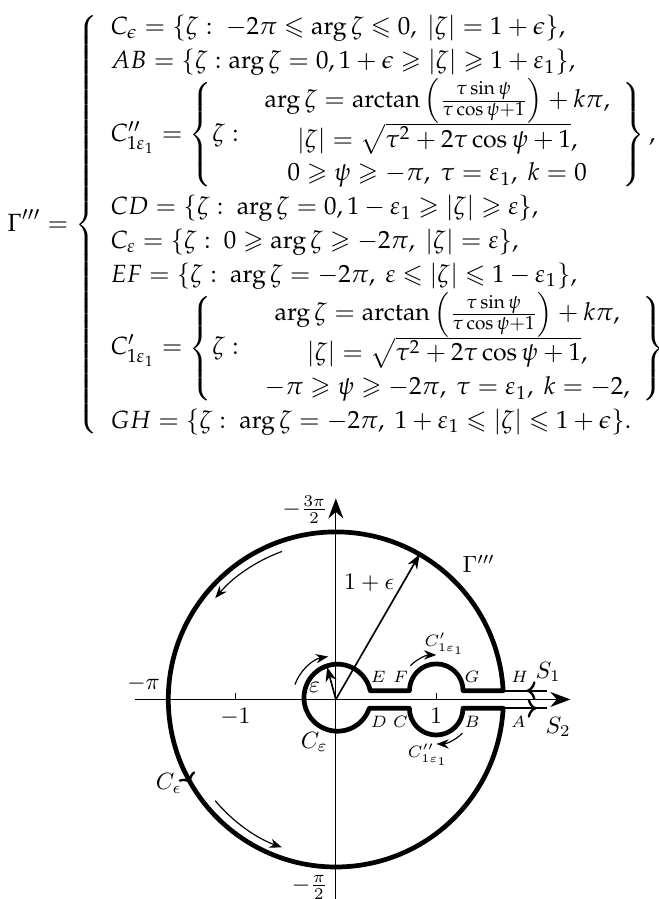
Figure 5. The auxiliary contour of integration Γ (cid:48)(cid:48)(cid:48)